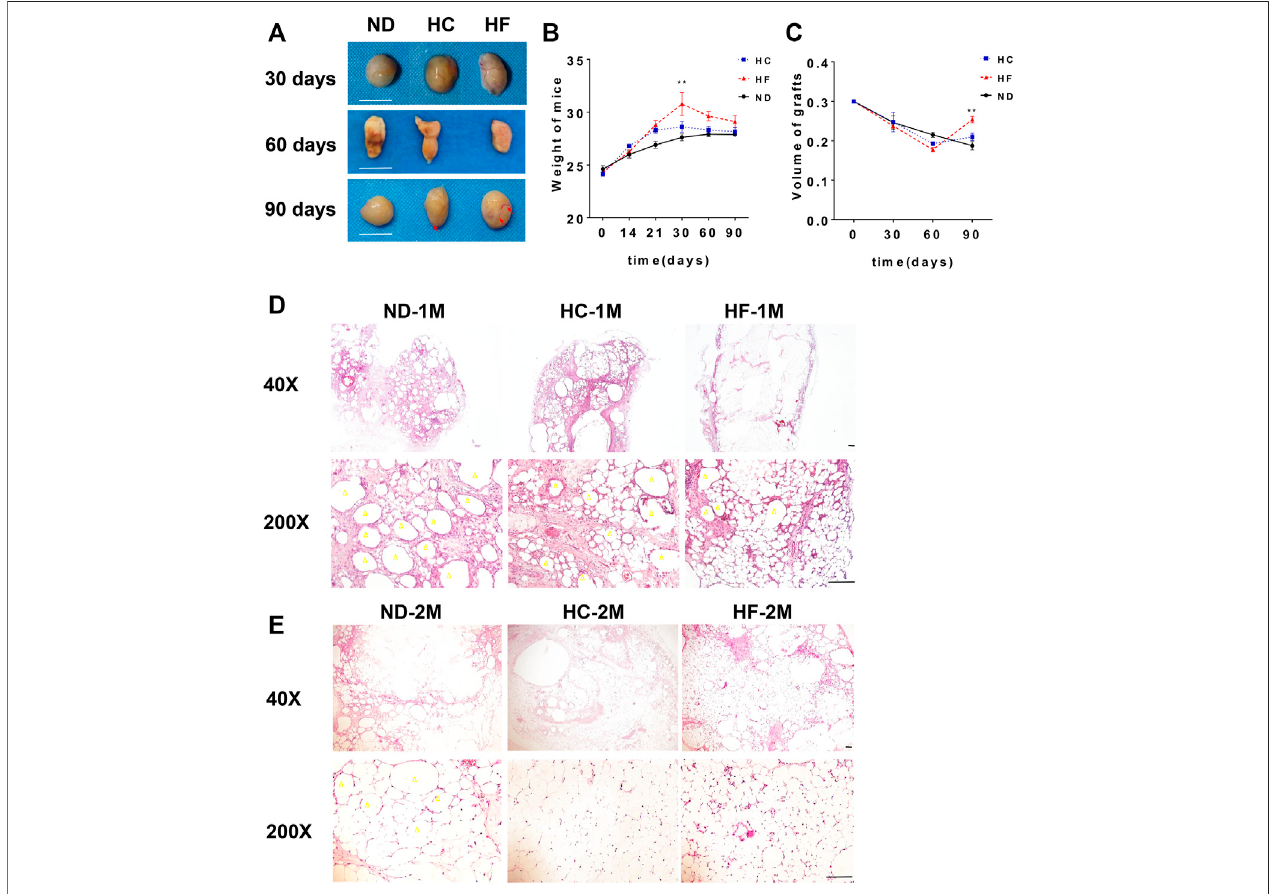
FIGURE2| Thechangesoffatgrafts inthe3studygroups (A) Representativegrossappearanceoftheharvested fatgrafts ondays 30,60,and90. (B) Theweight of mice on different diets and (C) the quanti fi cation of the graft volume. Scale bars = 10 mm Representative HE staining of the fat grafts obtained on day 30 (D) , and 60 (E) . Scale bars = 100 μ m. Grafts onday 30are marked as ND-1M, HC-1M, and HF-1M. Grafts on day 60 aremarkedas ND-2M, HC-2M,and HF-2M. Yellow arrow: oil cyst. ** p < 0.01 and * p < 0.05. n = 6 mice.